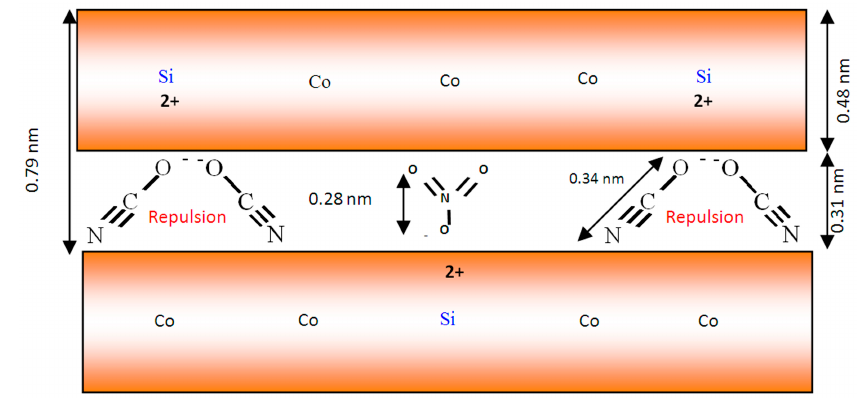
Figure 9. Schematic representation for the nanofibers and nanoneedles of Co–Si LDHs.